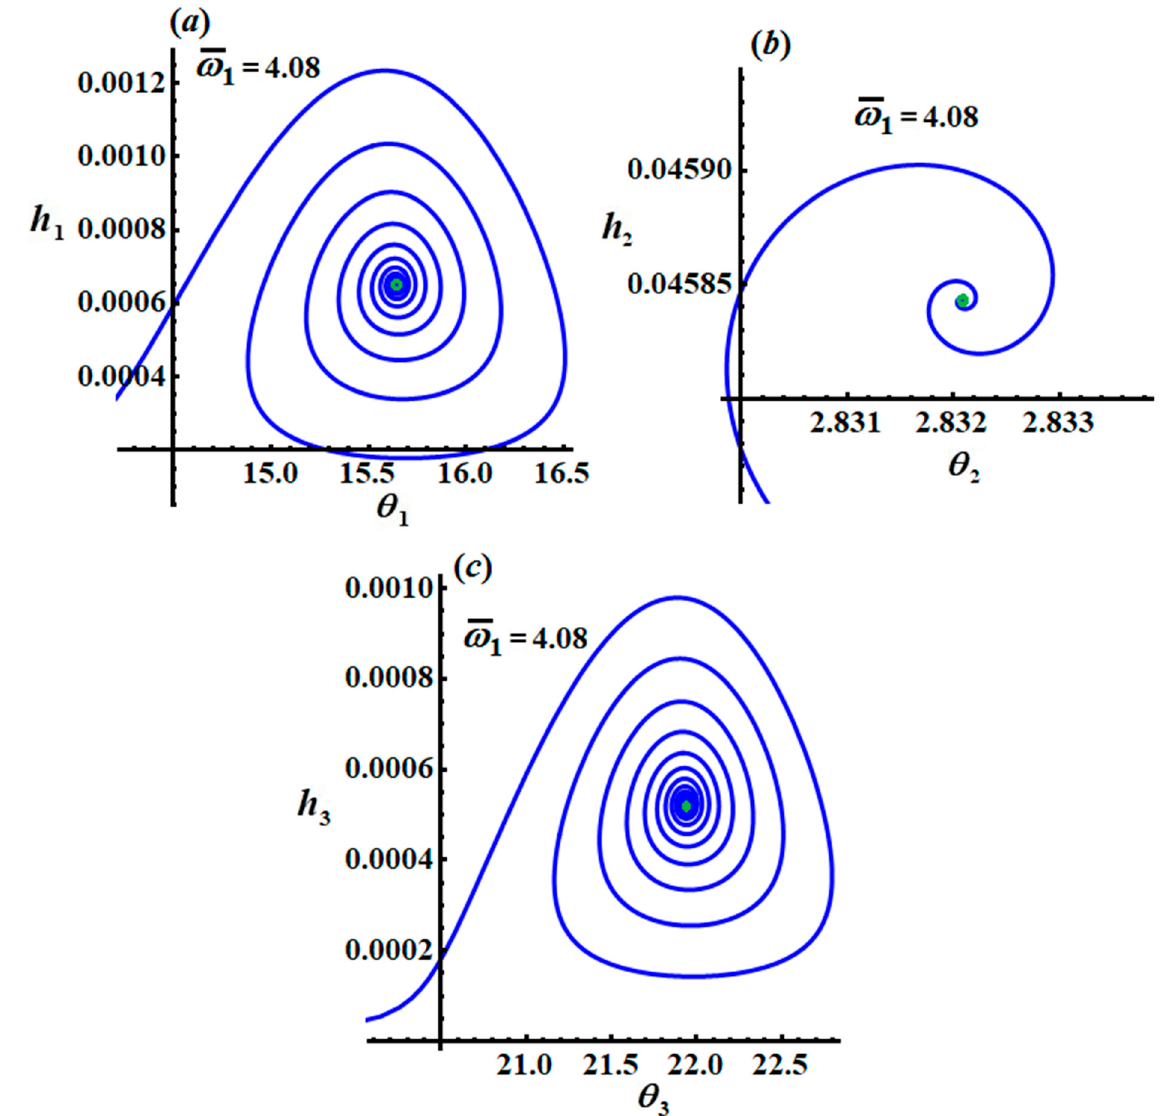
Figure 8. The amplitude modulation of h